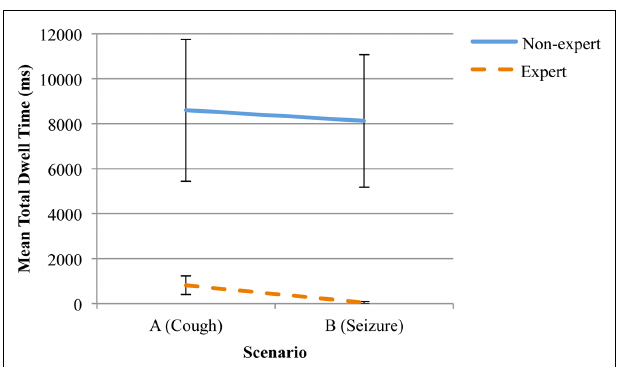
FIGURE 2 | Mean total dwell time (ms) and standard error on the “confederate nurse” for experts and competent non-experts, distributed across the two scenarios.